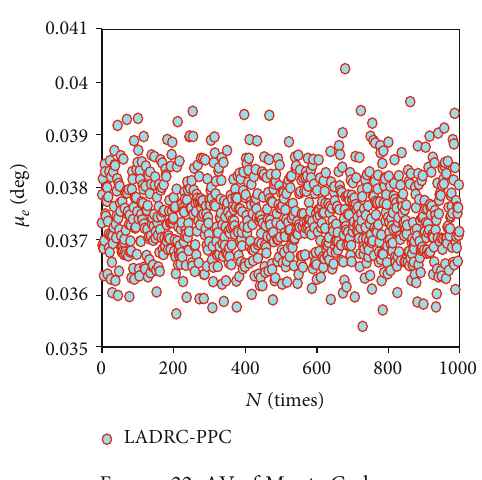
Figure 22: AV of Monte Carlo.